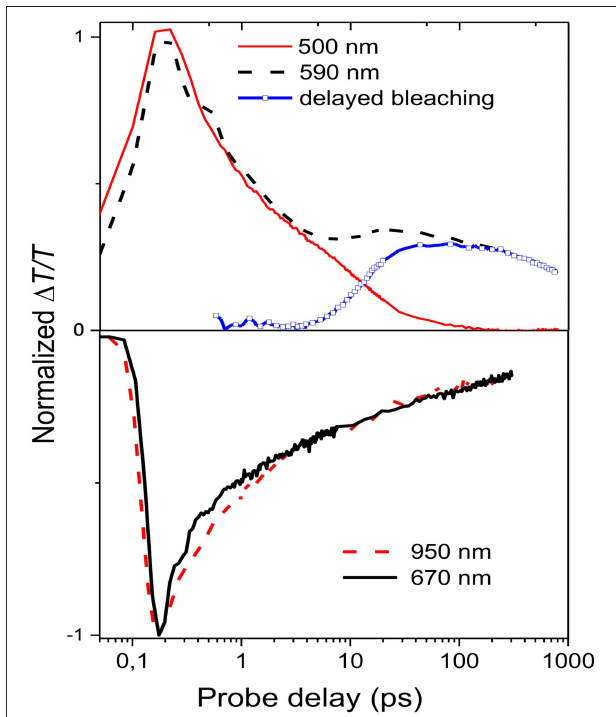
FIGURE 4 | Normalized decay traces at different wavelengths (see legend in the figure) The blue line representing the delayed bleaching is calculated by subtracting the normalized decay at 500nm from the one at